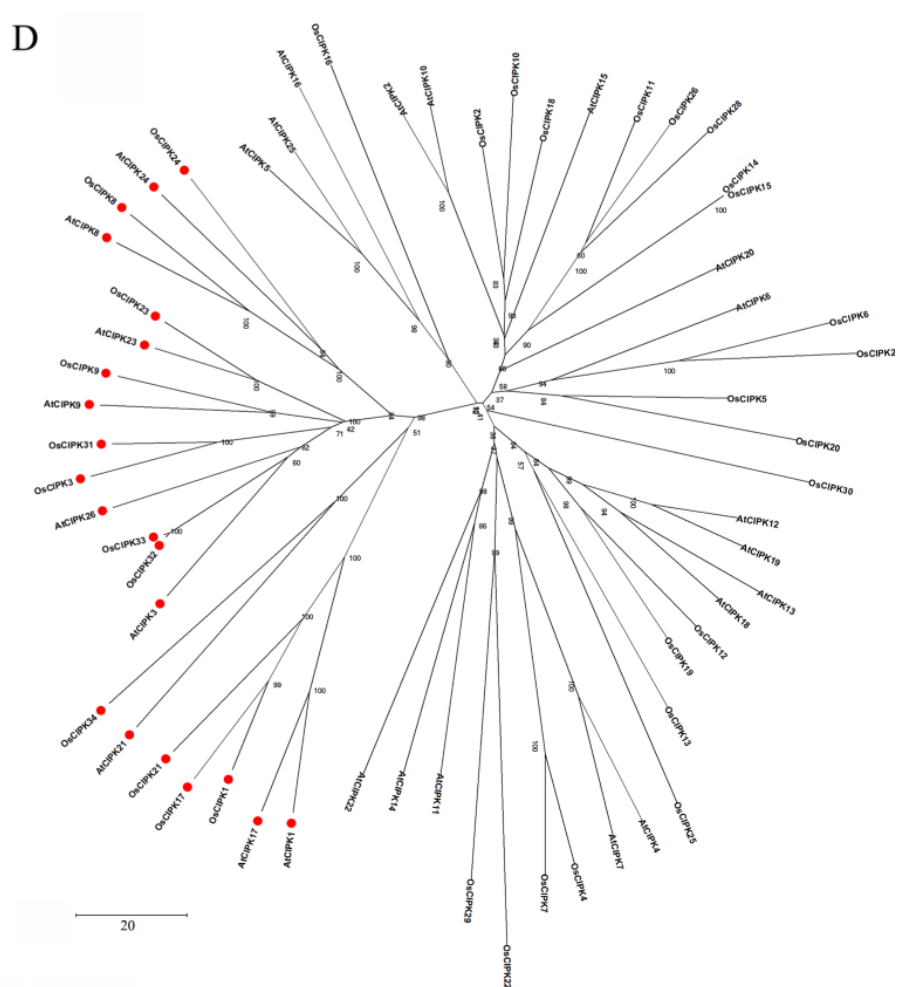
Figure 2. The domain structure and phylogenetic relationships of CBLs and CIPKs in Arabidopsis and rice ( Oryza sativa ). ( A ) CBLs contain four EF-hands that are separated by short amino acids with conserved numbers; ( C ) CIPKs contain conserved NAF motif and protein phosphatase interaction (PPI) motif which interact with CBLs and PP2Cs, respectively; ( B , D ) The phylogenetic relationships combined the classification of CBLs and CIPKs. The intron-rich CIPKs are distinguished with a red dot. Table 1. The CBL and CIPK families in plant species.